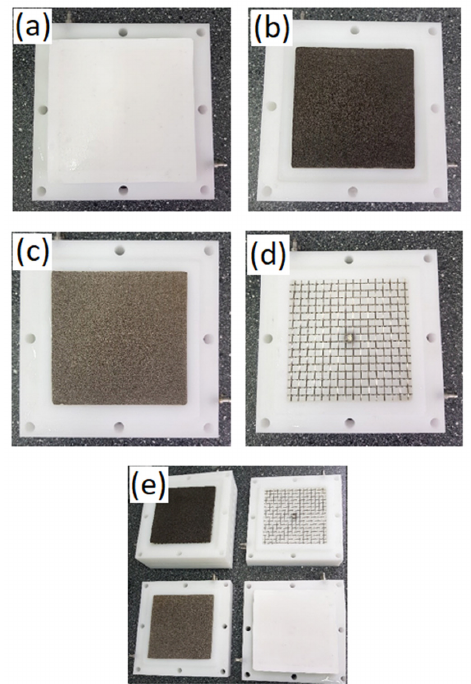
Figure 3. Structural elements of water electrolyser system: ( a ) membrane fitting in a single cell, ( b , c ) location of Pd-activated and unmodified Ni foam cathodes inside the cell respectively, ( d ) location of stainless-steel-made wire mesh and the cell’s connecting screws, ( e ) combining individual cells into an electrolyser stack (stainless-steel-made solution recirculation/gas discharge ports are clearly visible).